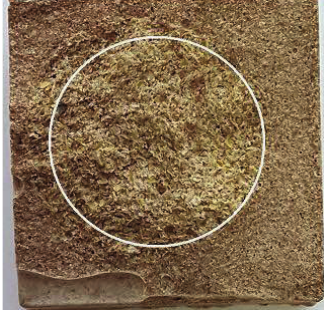
Fig. 8. The chip of the composite sample (in the centre of the granule).